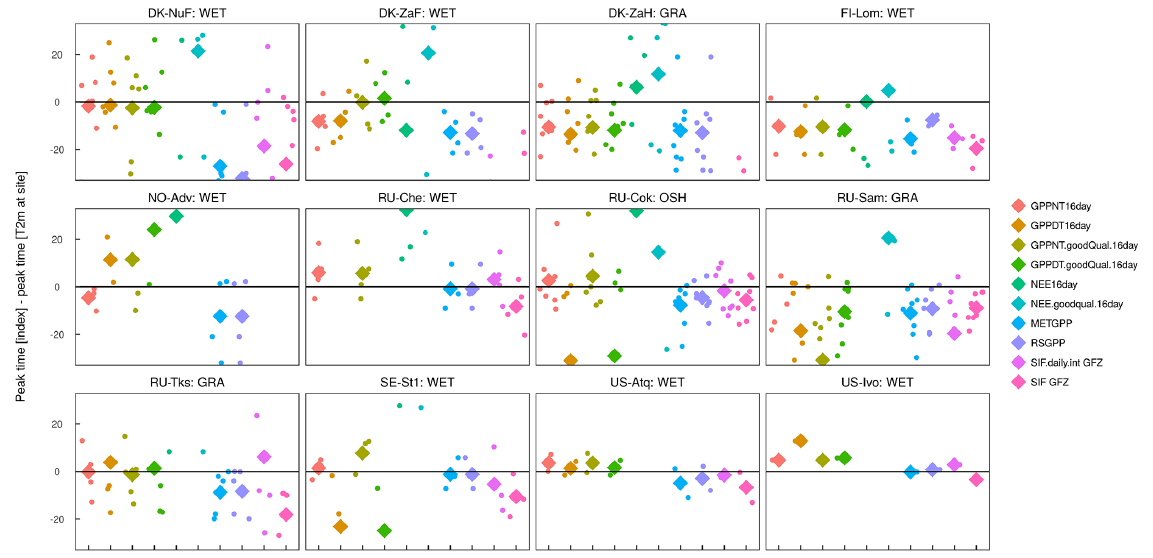
Figure A10. Difference in peak timing of the different indicators to site-level temperature over years at selected FLUXNET sites. Diamonds represent the average peak lag across all years per site and